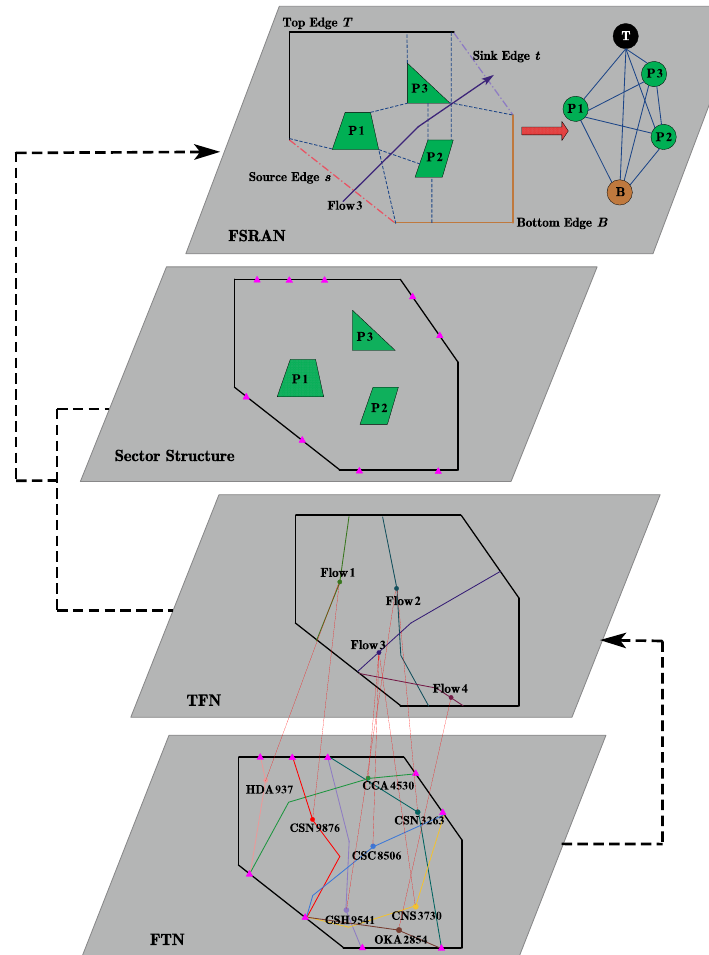
Figure 3. “Structure-flow” multi-layer network model.